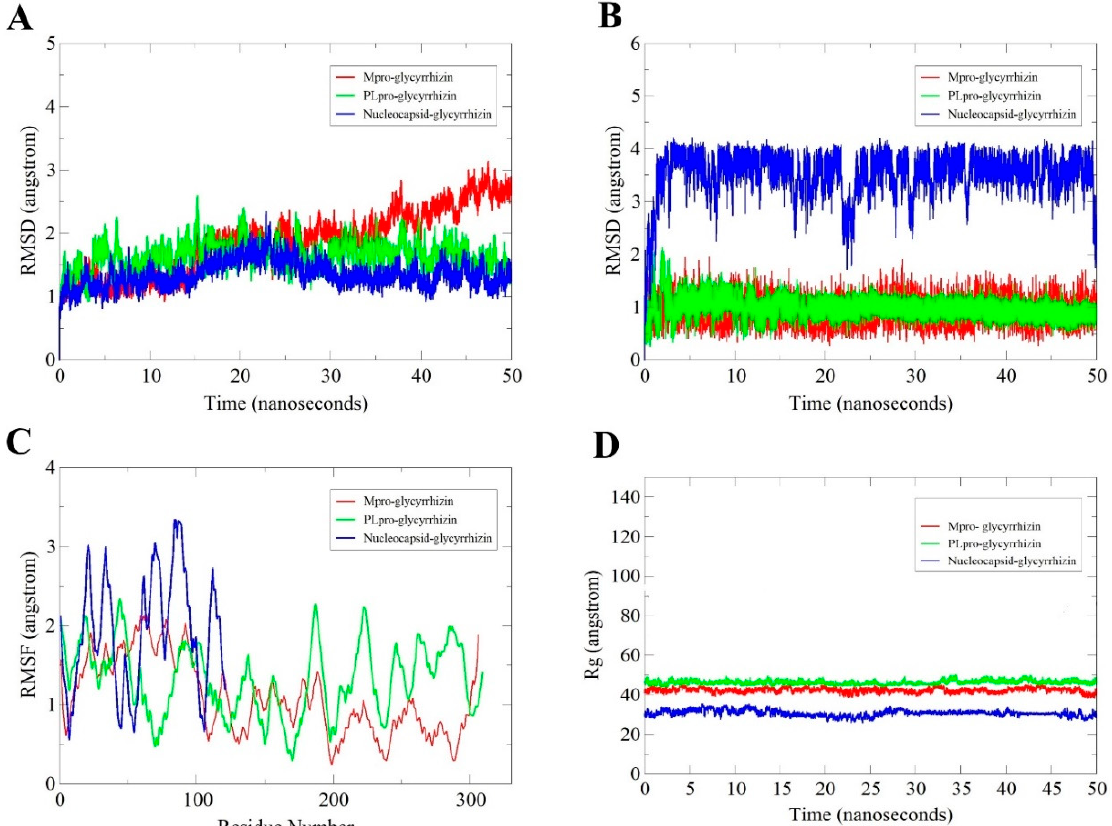
Figure 7. Statistical parameters calculated based on simulation trajectories. Receptor RMSD plots ( A ), glycyrrhizin RMSD plots ( B ), receptor RMSF ( C ), and receptor Rg ( D ).